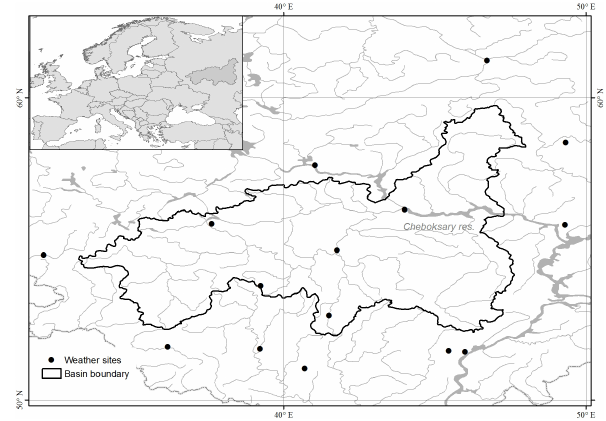
Figure 1. Case study: Cheboksary reservoir watershed.